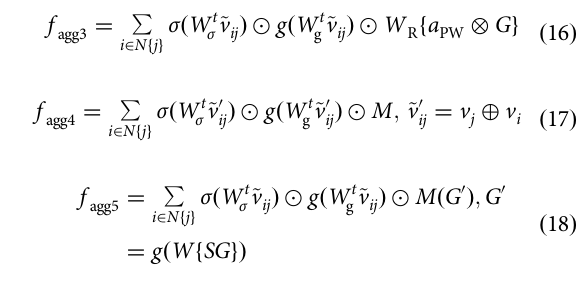
) of eight different supercells for f